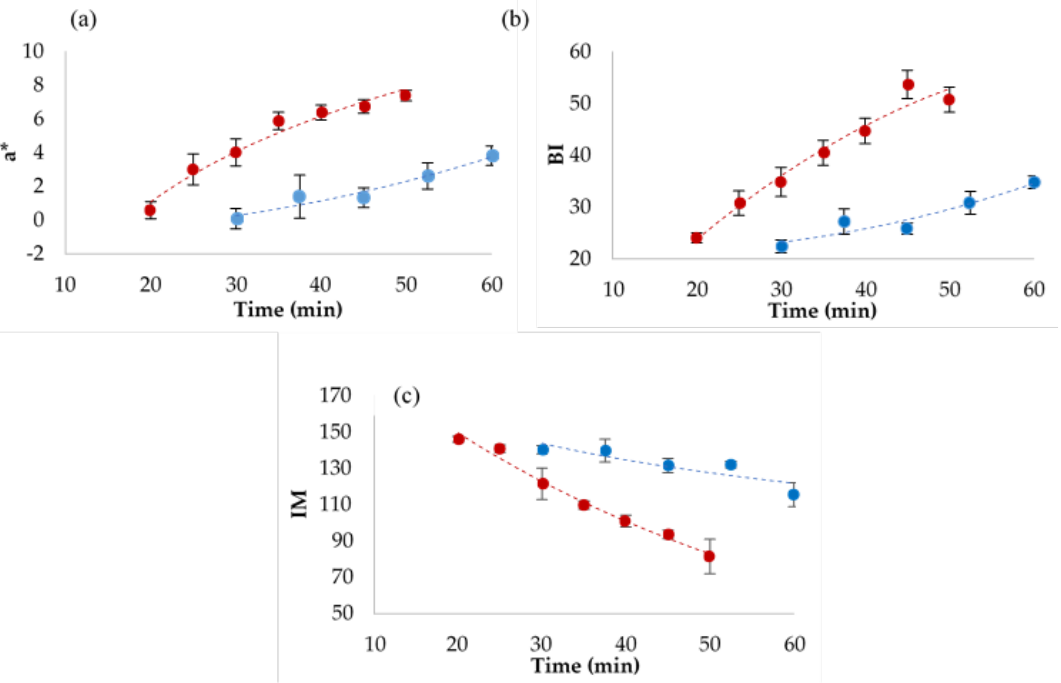
Figure 3. Redness ( a ), browning index ( b ) and intensity mean ( c ) of bread crust as a function of baking time at 200 °C (●) and 225 °C (●). Average of replicate trials, bars represent standard deviation.